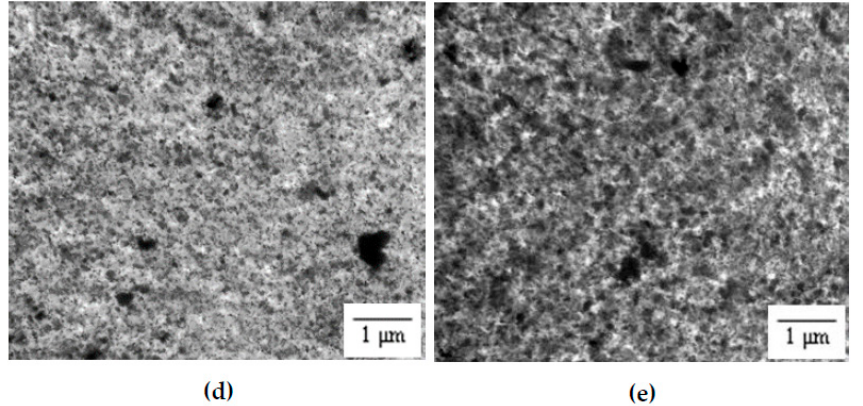
Figure 2. Transmitted light microscopic image of ( a ) PU − PEG 10,000, ( b ) PU − PEG 8000, ( c ) PU − PEG 6000, ( d ) PU − PEG 4000, and ( e ) PU − PEG 2000.